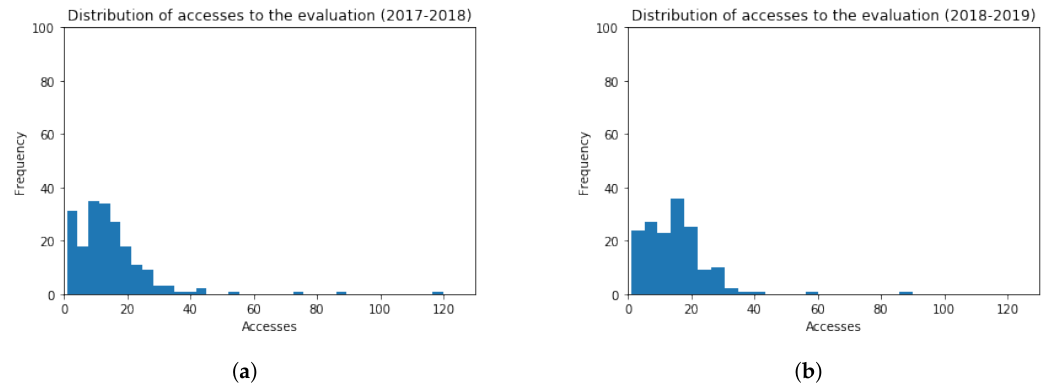
Figure 12. Histogram Graphs for the Number of Accesses to the Evaluation Resources. ( a ) 2017–2018 ( b )